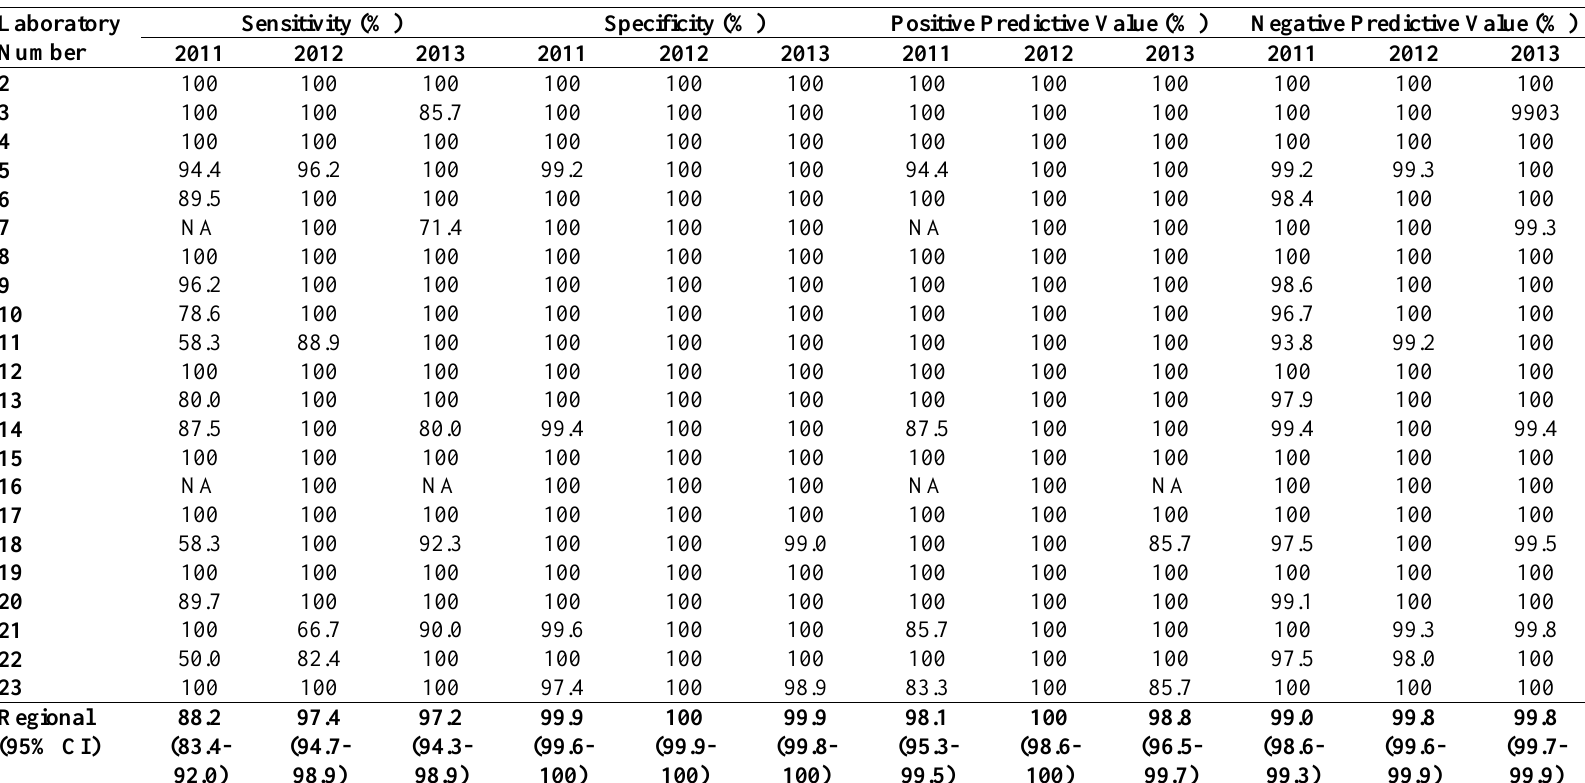
Table 4: Percentage of sensitivity and specificity of smear microscopy, by laboratory